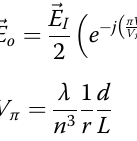
To explain the process of such runtime architecture intuitively, time-series diagram is plotted in Fig. 4c and Supplementary Fig. S7. While V increases before reaching C1